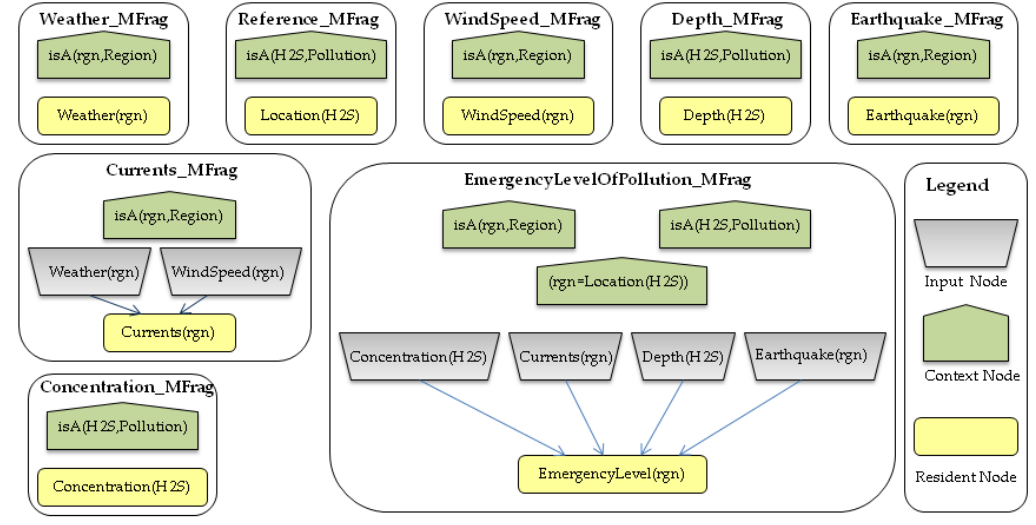
Figure 10. The probabilistic ontology for estimating emergency level of pollution in an MEBN theory.